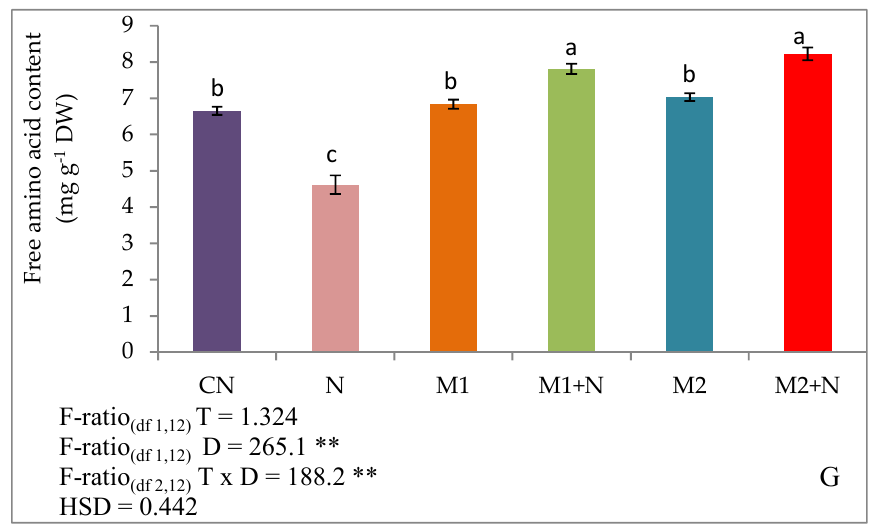
Figure 5. Effect of M1 (10 9 cells / mL) and M2 (10 9 cells / mL) on different Osmoprotectants ( A ) Total osmolytes ( B ) Total carbohydrates, ( C ) Total reducing sugars ( D ) Trehalose content ( E ) Glycine betaine content ( F ) Proline content ( G ) Free amino acid content in 45-days old L. esculentum under PPN infection. Data is presented as means of three replicates ± SD and HSD values. F ratio values, * indicates significance at p ≤ 0.05 and ** indicates significance at p ≤ 0.01). Different letters on the table indicate that mean values of treatments are significantly different at p < 0.5 according to Tukey’s multiple comparison test.